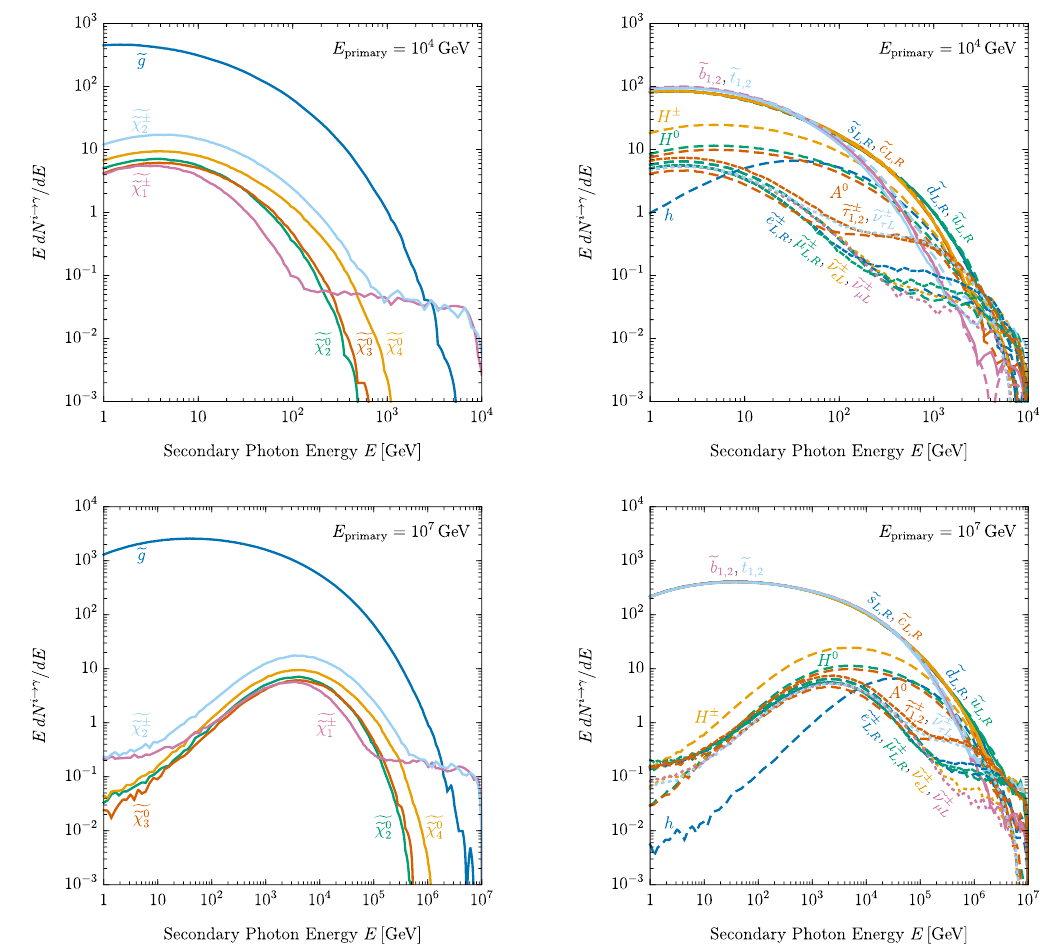
Figure 10 . The secondary photon spectra per primary particle for the MSSM fermions (left) and bosons (right) at a primary energy of 10 4 GeV (top) and 10 7 GeV (bottom). The artefacts are Monte Carlo error for rare processes and do not lead to a significant error in the total secondary